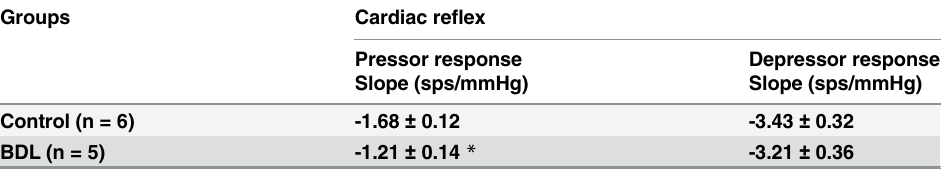
Table 3. Slope values obtained from the linear regression lines in the control or BDL